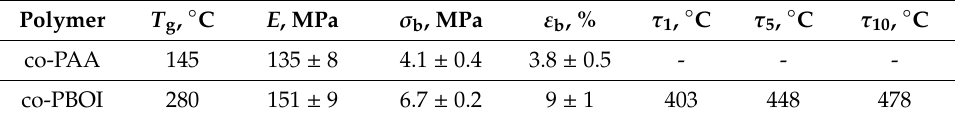
Table 2. Mechanical and thermal properties of asymmetric membranes.